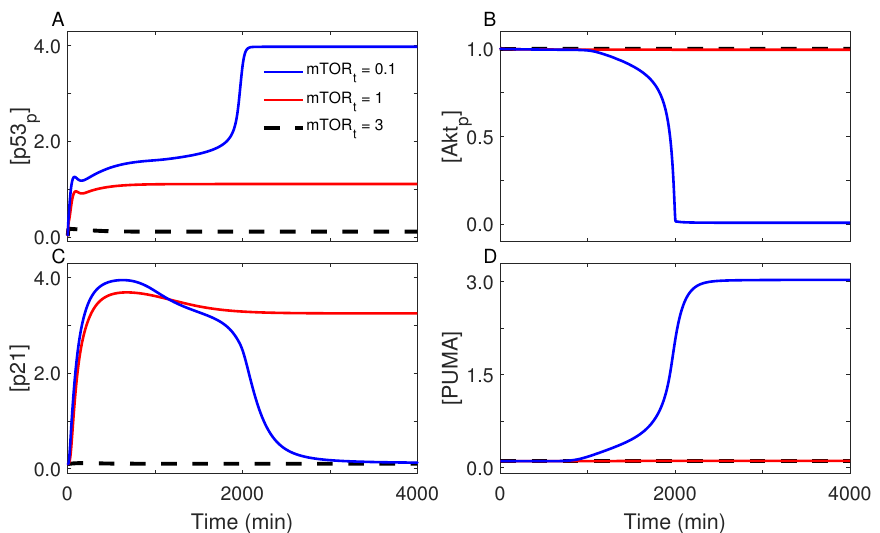
Figure 7. Role for mTOR in cell-fate decision. Shown are time courses of the levels of p53 p ( A ), Akt p Figure 7. 7 ( B ), p21 ( C ), and PUMA ( D ) at C g = 0.2 mM for mTOR t = 3 (dashed), 1 (red), or 0.1